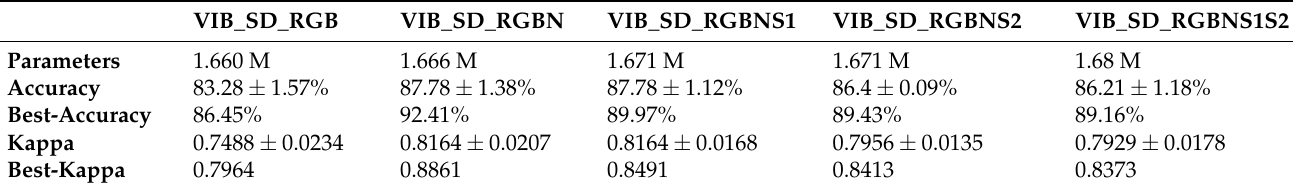
Table 8. Performance of models using variant bands based on 10